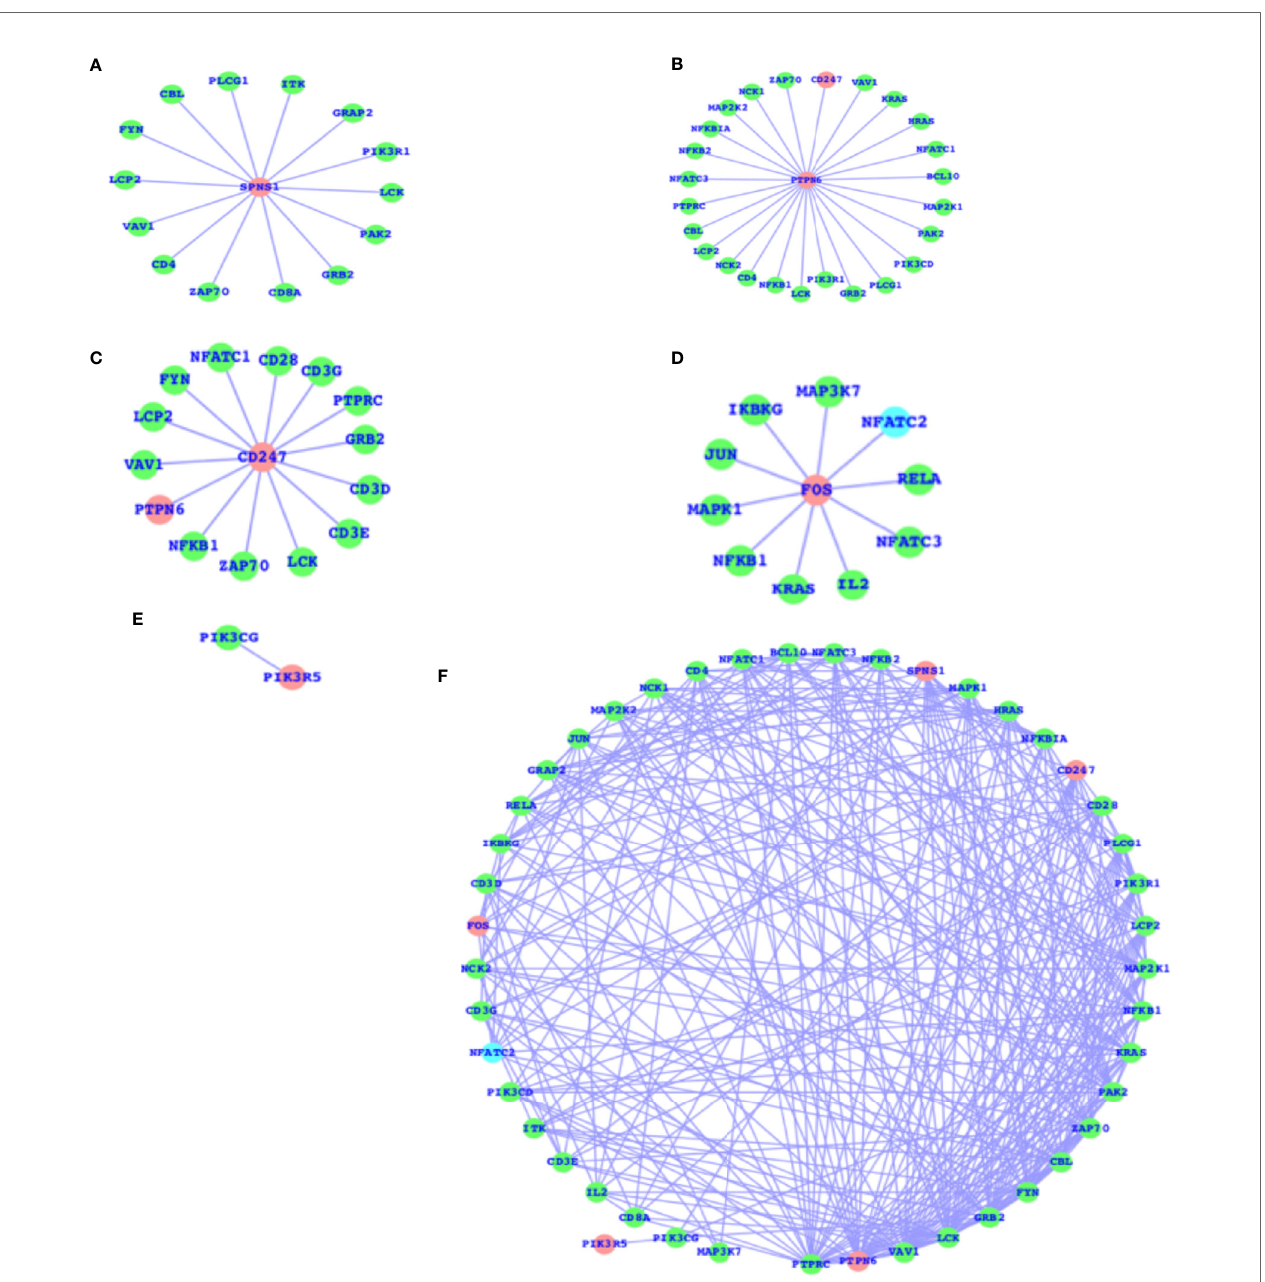
FIGURE 3 | DEGs of T2D and TCR signaling network. (A) SPNS1 network, (B) PTPN6 network, (C) CD247 network, (D) FOS network, (E) PIK3R5 network, and (F) the overall association between these T2D DEGs and the TCR genes and the